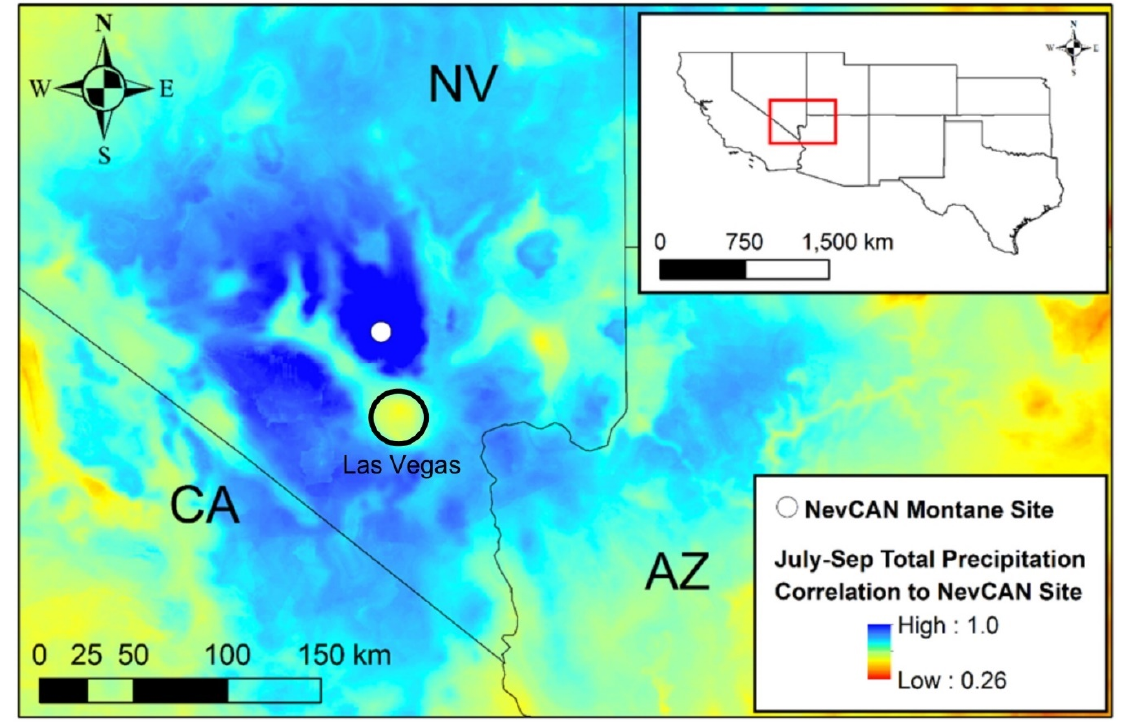
Figure 1. Interpolated pseudo-color map of Pearson’s linear correlation between July–September total precipitation at our mountain site (solid white circle) and at each 800-m PRISM grid cell in the surrounding region during 1895–2015. All correlations were statistically significant ( p -value < 0.01), with lower values usually corresponding to lower elevations, such as the Las Vegas valley (black circle).